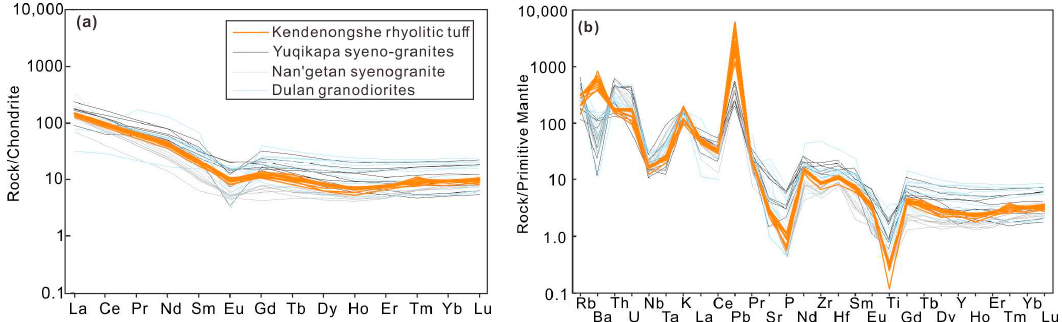
Figure 6. ( a ) The chondrite-normalized REE contents and ( b ) primitive mantle-normalized immobile trace element content diagrams for the Kendenongshe rhyolitic tuff. Data source: the OIB and N-MORB lines were taken from Reference [31]; Dulan granodiorites in the NEKO were taken from Reference [32]; Nan’getan syenogranite in the NEKO were taken from Reference [33]; Yuqikapa syenogranites in West Kunlun were taken from Reference [35].